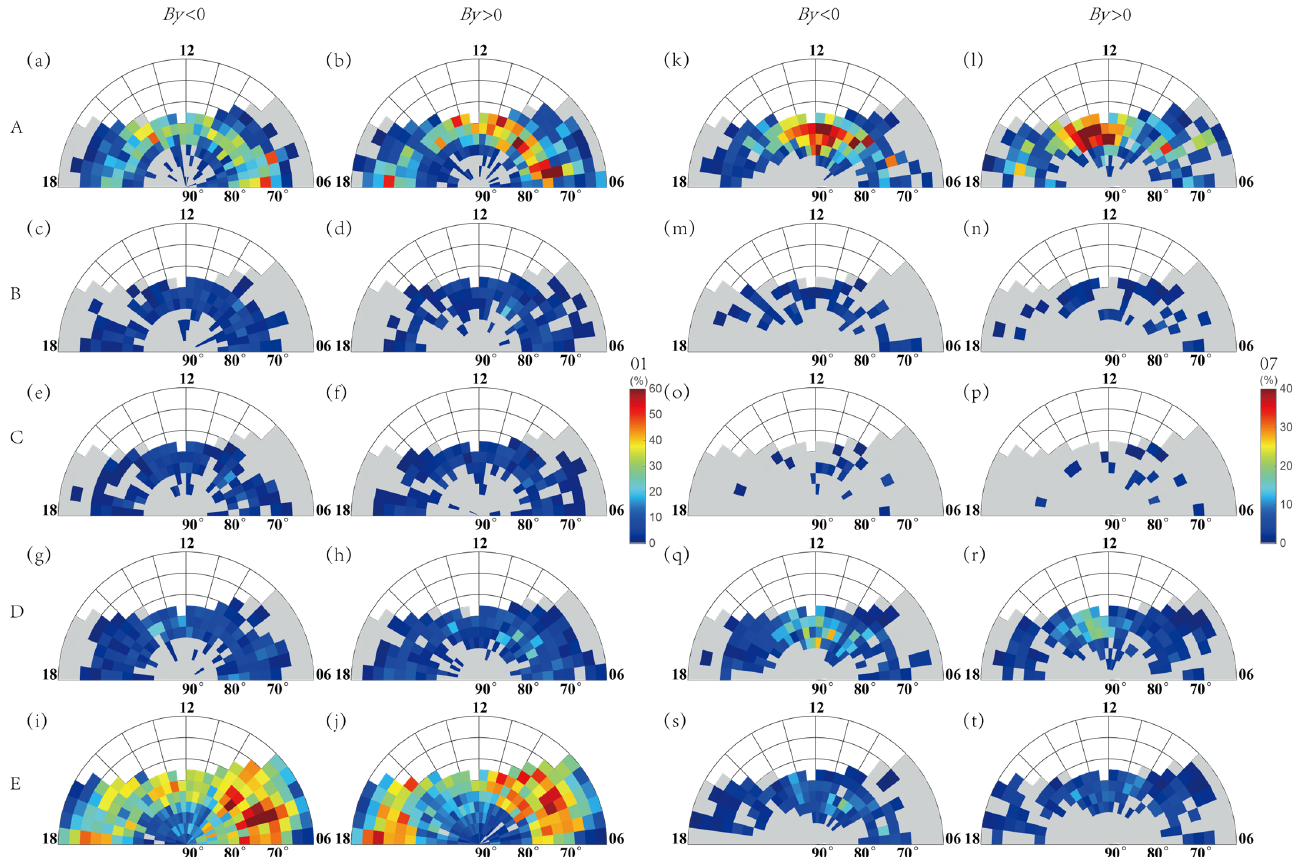
Figure 6. Temporal–spatial distribution of different types of ion upflows under different direction of IMF By . From top to bottom are ion upflows of type A to E, respectively. ( a – j ) statistics for January, ( k – t ) statistics for July.